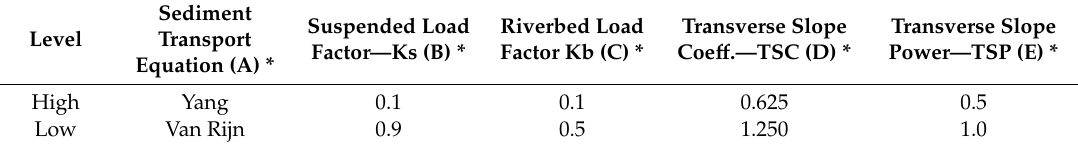
Table 4. Factors (Calibration parameters) for 2 k experimental design.